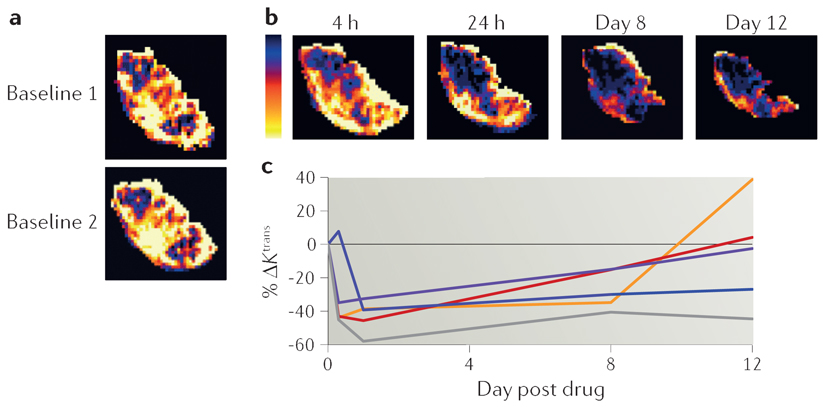
Example DCE–MRI data from patients with stage IV colorectal cancer receiving bevacizumab. a | Double baseline scanning enables calculation of IB precision; here, Ktrans has been calculated in a liver metastasis on two scan visits performed 24 h apart. b | Serial mapping of Ktrans in the same tumour reveals pharmacodynamic (PD) changes within 4 h of initiating therapy that were maintained to day 12. c | The IB ΔKtrans is shown for tumours from six patients82.